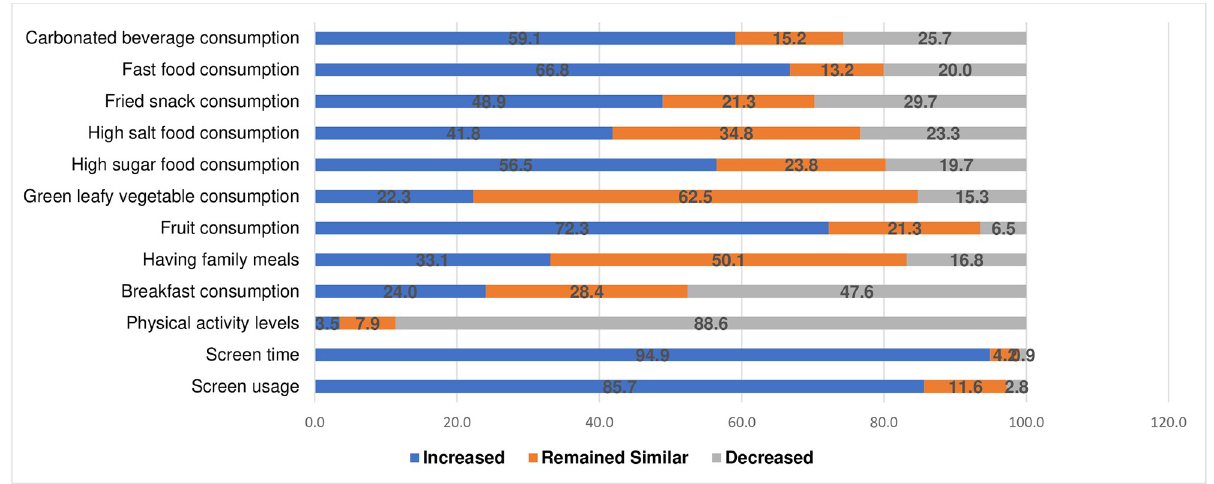
Fig 1. Reported frequency of screen usage, eating habits, and physical activity levels before and during COVID-19.